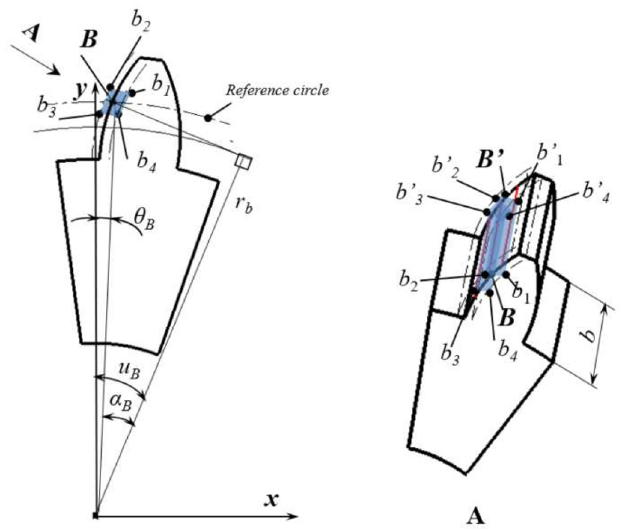
Fig. 3. Tolerance zone of tooth surface.